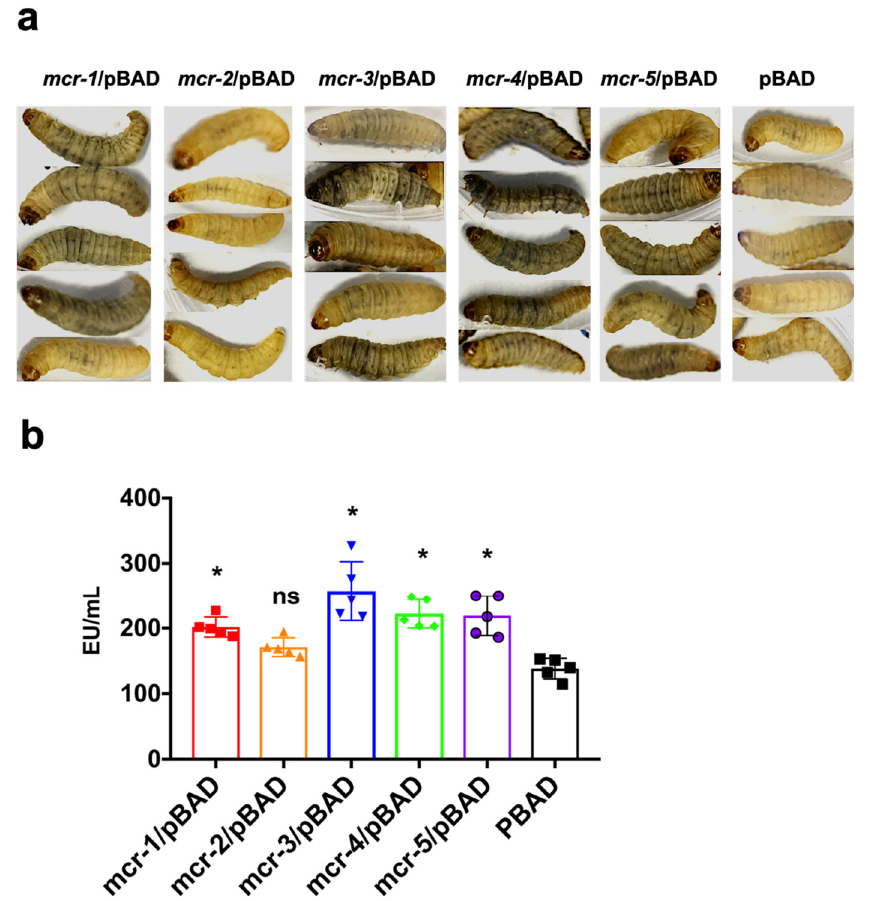
Figure 5. Bacterial virulence evaluated in a G. mellonella model. ( a ) Melanization of G. mellonella infected with MCR-expressing strains. ( b ) LPS concentrations in G. mellonella after infection. * p < 0.05, ns: not